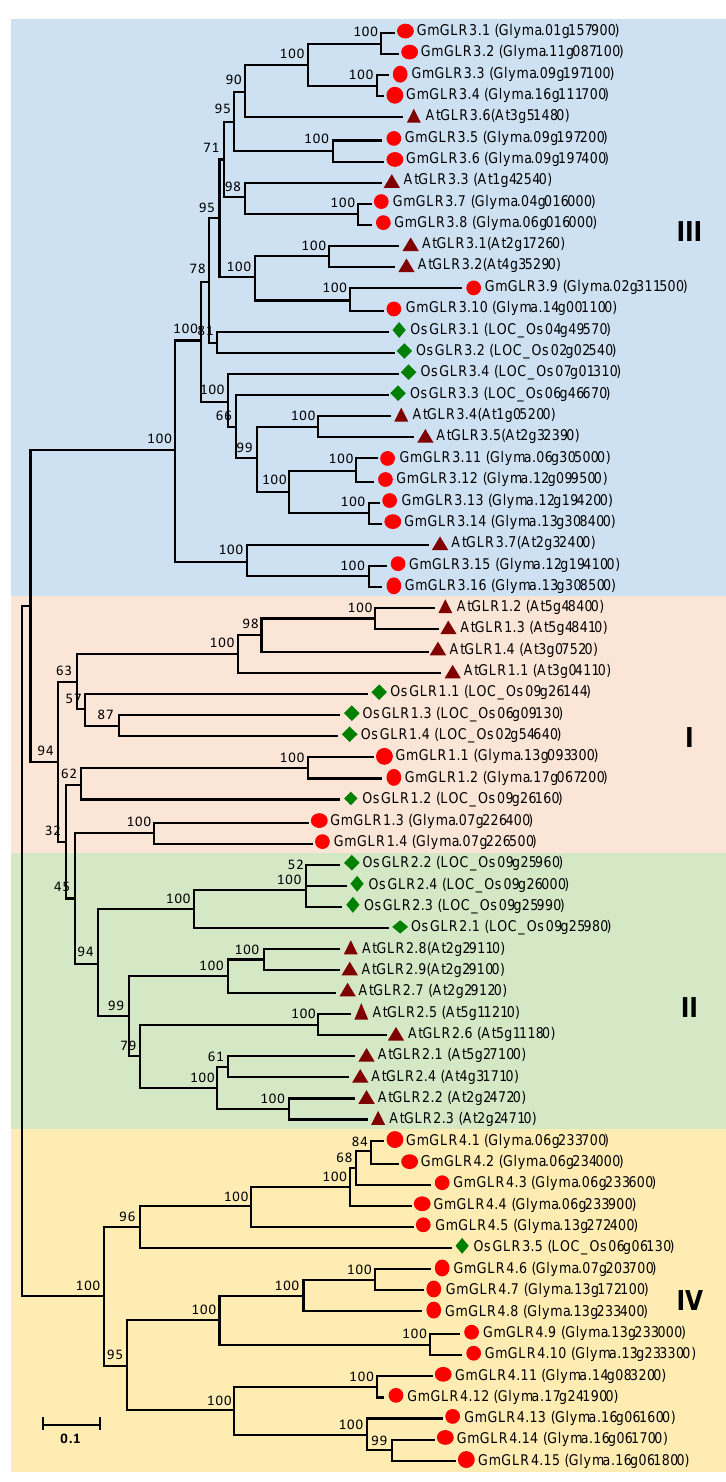
Figure 6. Unrooted phylogenetic tree of the glutamate receptor-like (GLR) family proteins from soybean ( Glycine max ), rice ( Oryza sativa ), and Arabidopsis thaliana . Soybean GLRs are marked with red circles, Arabidopsis GLRs were marked with purple triangles, while rice GLRs were marked with green diamonds. The bar indicates the relative divergence of the sequences examined, and bootstrap values are displayed next to the branch. Roman numerals designate the